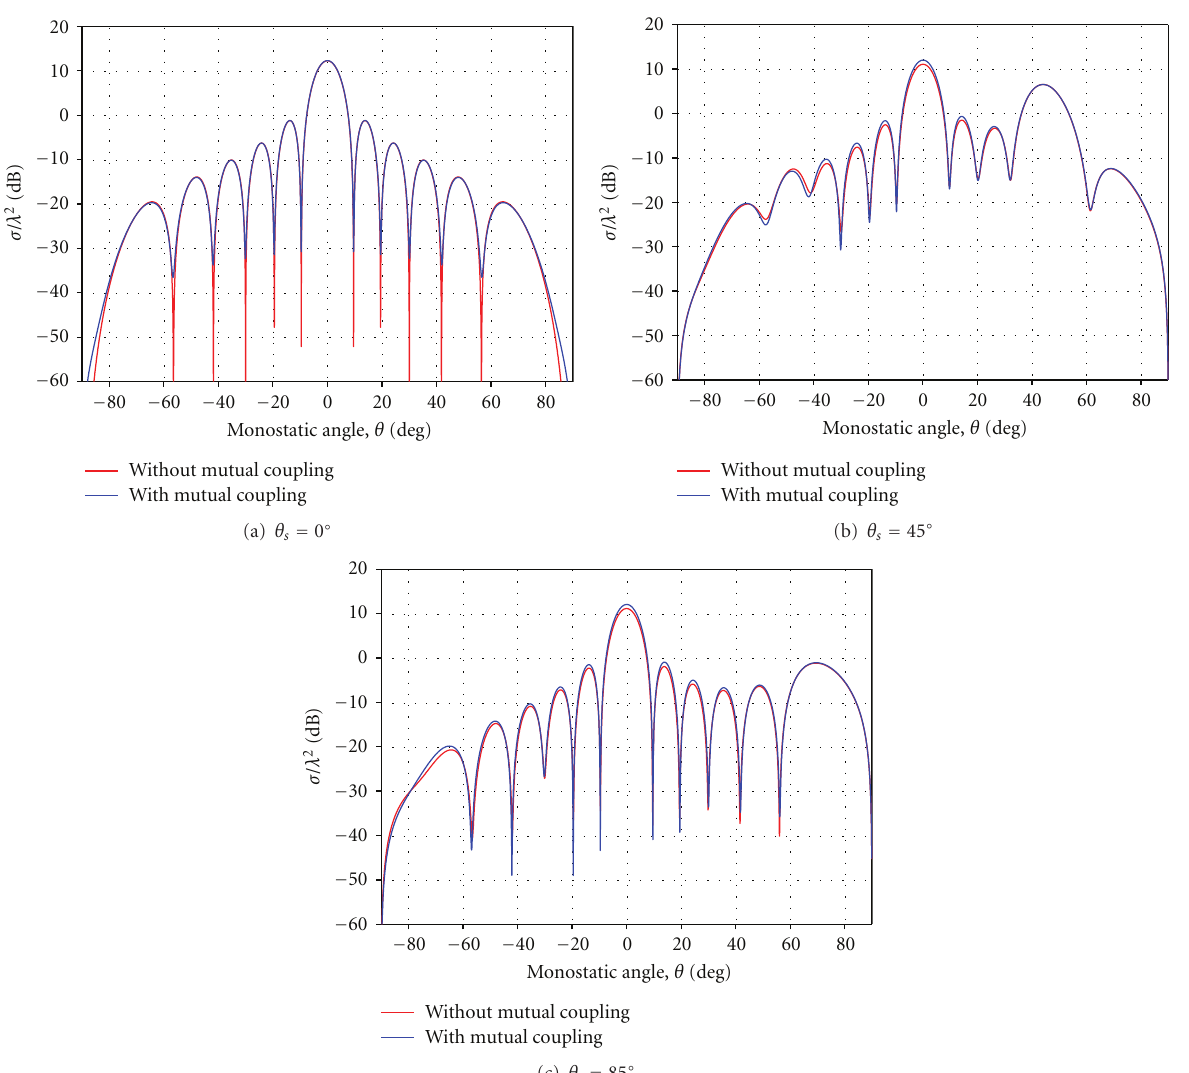
Figure 18: E ff ect of mutual coupling on RCS of series-fed linear collinear dipole array of N = 30, ψ = π/ 2, d = 0 . 1 λ , l = 0 . 5 λ , a = 10 − 5 λ , Z 0 = 75 Ω , and Z l = 150 Ω ; unit amplitude uniform